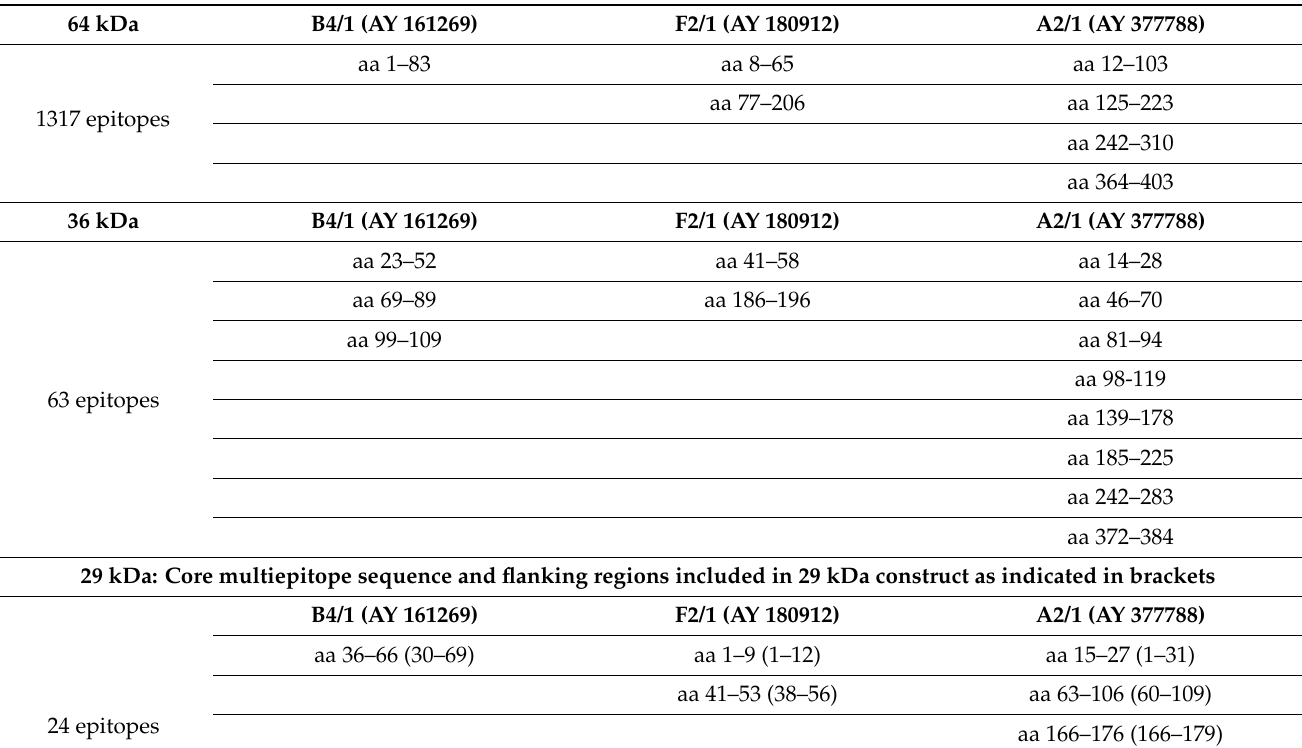
Table 1. Multiple overlaying regions of epitopes used in designing the multiepitope